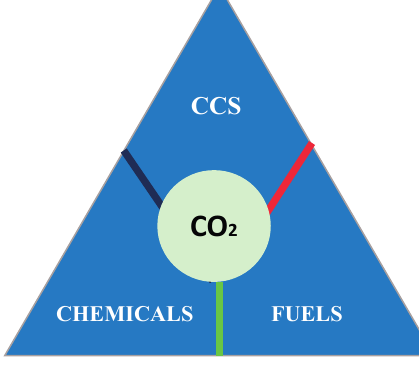
Figure 1. Possible strategies of reducing CO 2